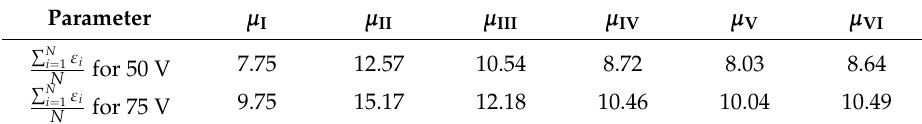
Table 2. Averages percent value of the relative error for N = 11 considered points of the